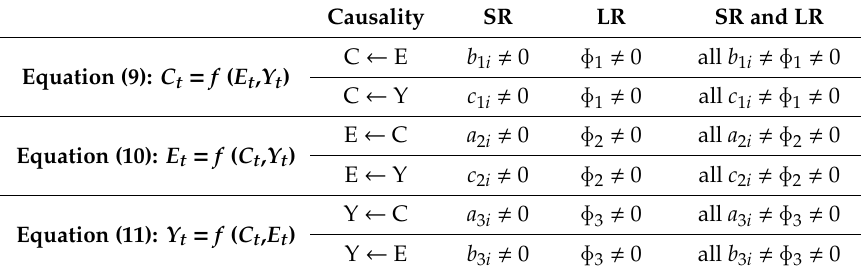
Table 2. Causality in vector error correction model (VECM)